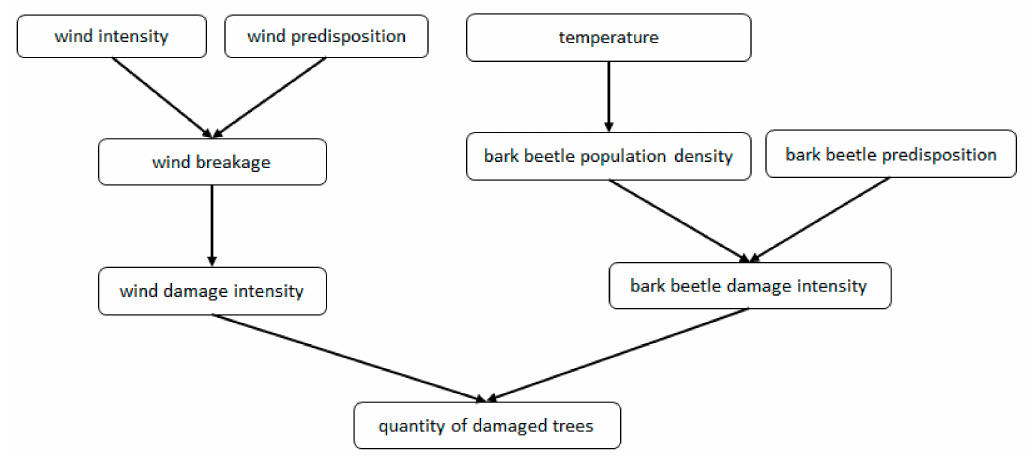
Figure 1. Influence diagram for the damaged trees network relating wind and bark beetle disturbance agents to predict quantity of damaged tress.